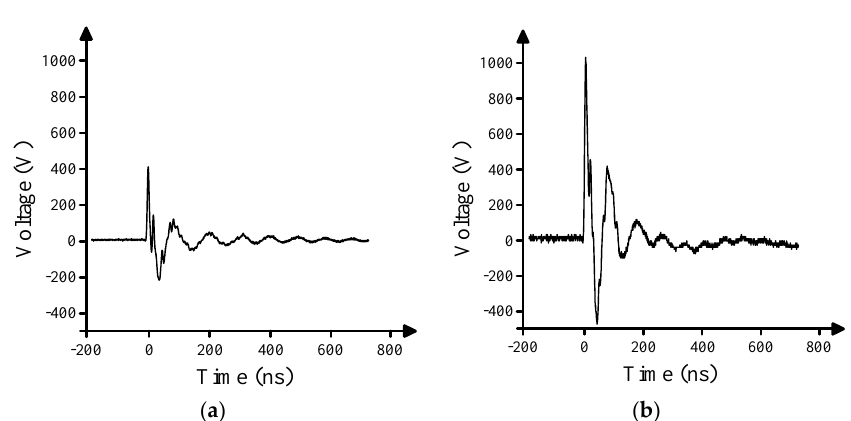
Figure 6. Interference waveform measured at the signal input port A: ( a ) Grounding configuration 1 (chassis floating). ( b ) Grounding configuration 2 (chassis grounding).